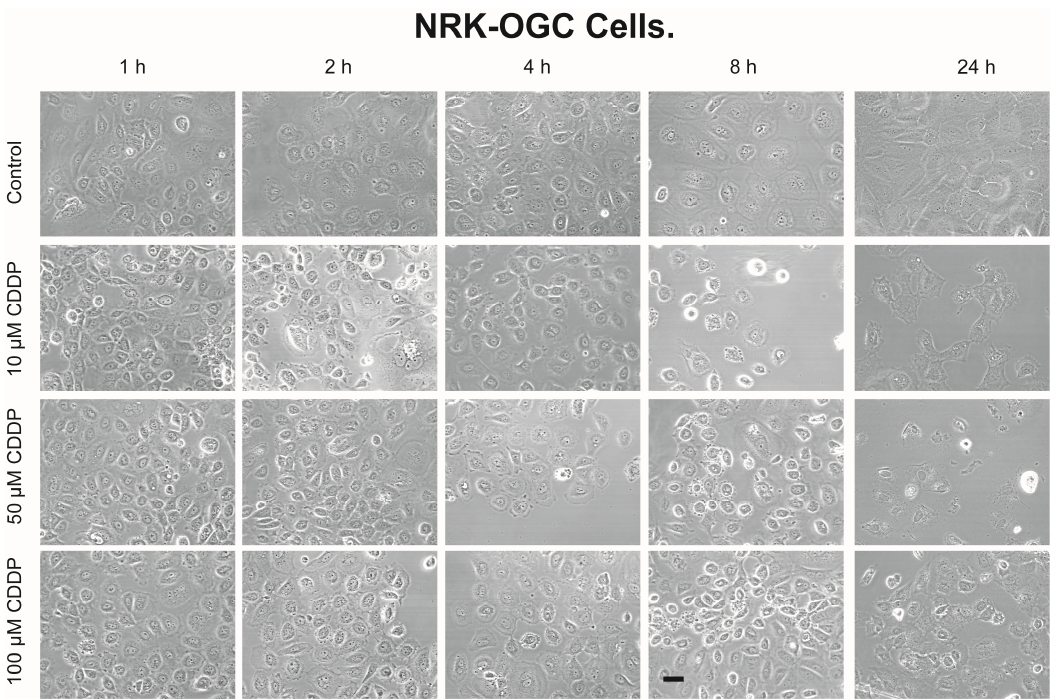
Figure 4. Morphology of NRK-52E-OGC cells incubated with CDDP. Confluent, NRK-52E cells overexpressing OGC (NRK-52E-OGC) were incubated for up to 24 h with 0, 10, 50, or 100 µM CDDP. Photomicrographs were obtained on a Zeiss Triple Laser Scanning confocal microscope at an initial magnification of 196 × . Bar = 5 µ